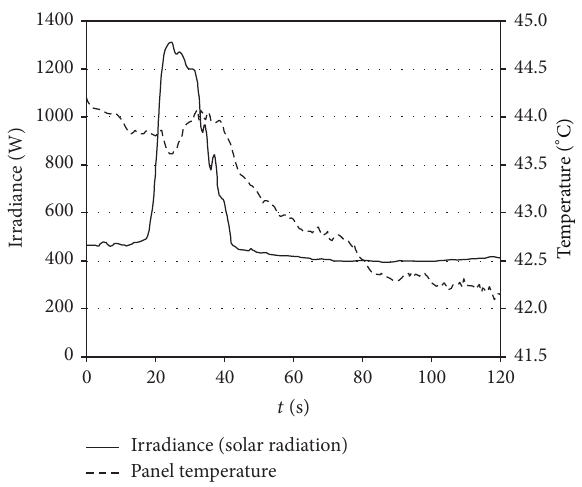
Figure 15: Power from an 8-panel photovoltaic facility calculated with the proposed methodology and P&O MPPT algorithm (scaled results and results with power losses considered). The results from the testing measurements [50] (considering P&O and INC MPPT algorithms) are also included in the figure (P&O: blue line; INC: red